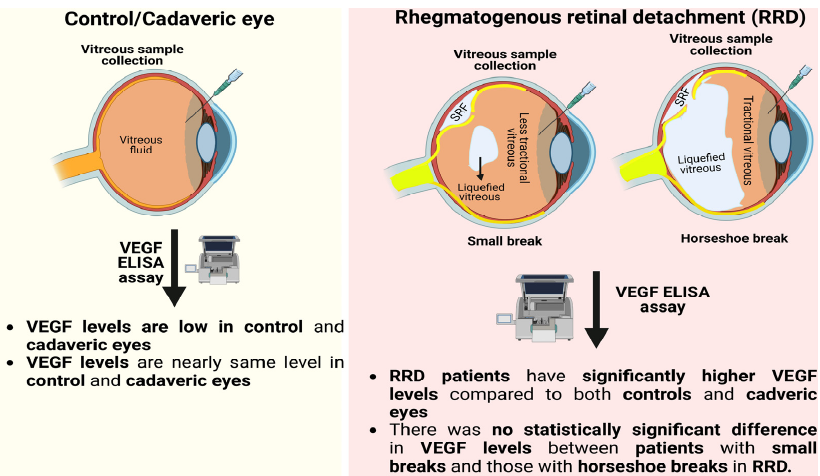
Figure 2. Schematic showing increased VEGF levels in the vitreous of patients with primary RRD compared to controls and cadaver eyes. In patients with primary RRD, the size of the break does not appear to have any effect on the patient’s VEGF levels. SRF represents sub-retinal fluid.